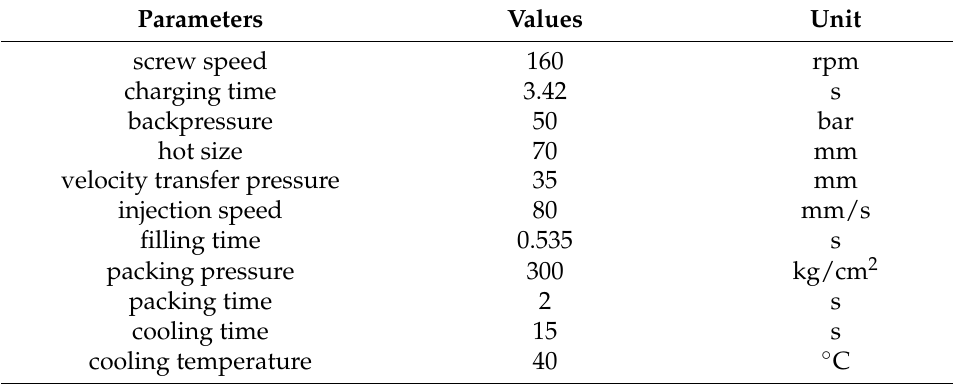
Figure 1. Manufacturing steps of hybrid fiber overmolded composite. Table 2. Constant parameter